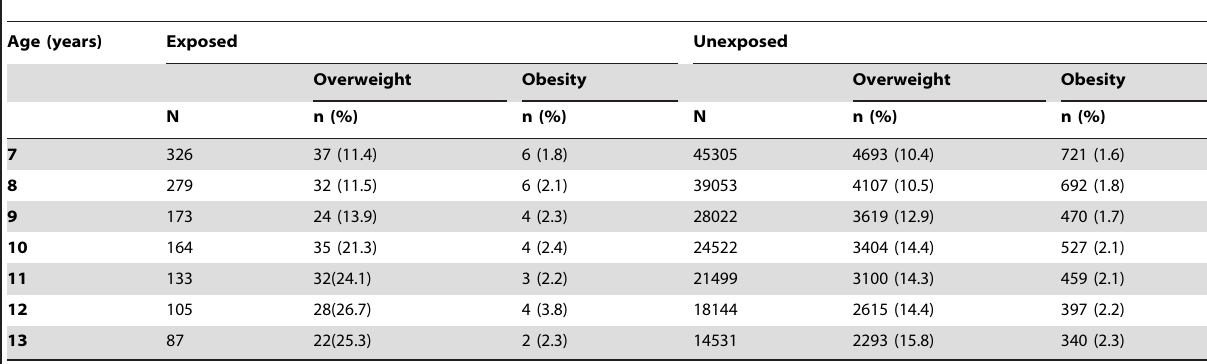
*Chi-square ( x 2 ) test for association between exposure and outcomes of overweight and obesity at a specific age: 7 years: P=0.6051; 8 years: P=0.6502; 9 years: P=0.7080; 10 years: P=0.0060; 11 years: P=0.0016; 12 years: P=0.0004; 13 years: